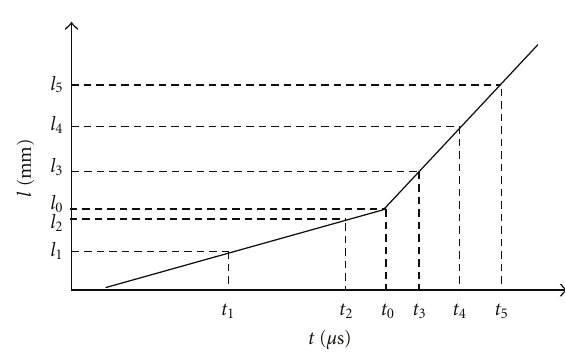
Figure 3: Time-distance